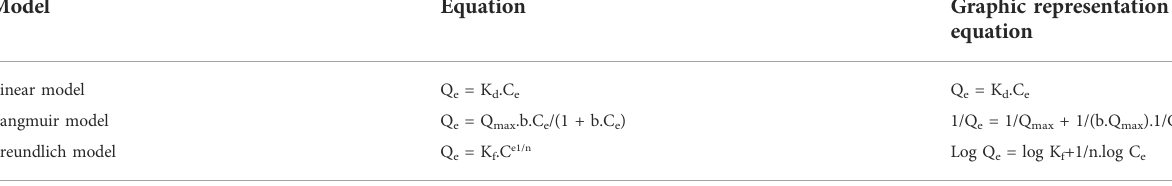
Q e ( μ g/g),sorptionconcentrationofPAHstoMPsatequilibrium;C e ( μ g/L),equilibriumsolutionphaseconcentrationofPAHs;K d ,partitioncoef fi cientofPAHbetweenplastic(MPs)and aqueous phase at equilibrium (L/g); Q max , maximum amount of the PAH per weight unit of MPs ( μ g/g); b, Langmuir constant related to the af fi nity of binding sites (L/ μ g); K f , sorption capacity (L/g); 1/n, degree of dependence of sorption at equilibrium.